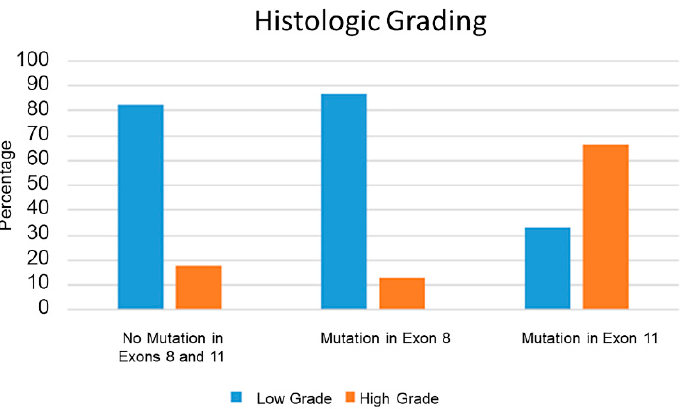
Figure 1. Histogram of percentage of low- (blue) and high-grade (orange) subcutaneous mast cell tumors associated with each of the three groups of different mutation status. A high grade was significantly associated with an internal tandem duplication mutation in exon 11 ( p < 0.001), but not with a mutation in exon 8 or with no mutations in exons 8 and 11.